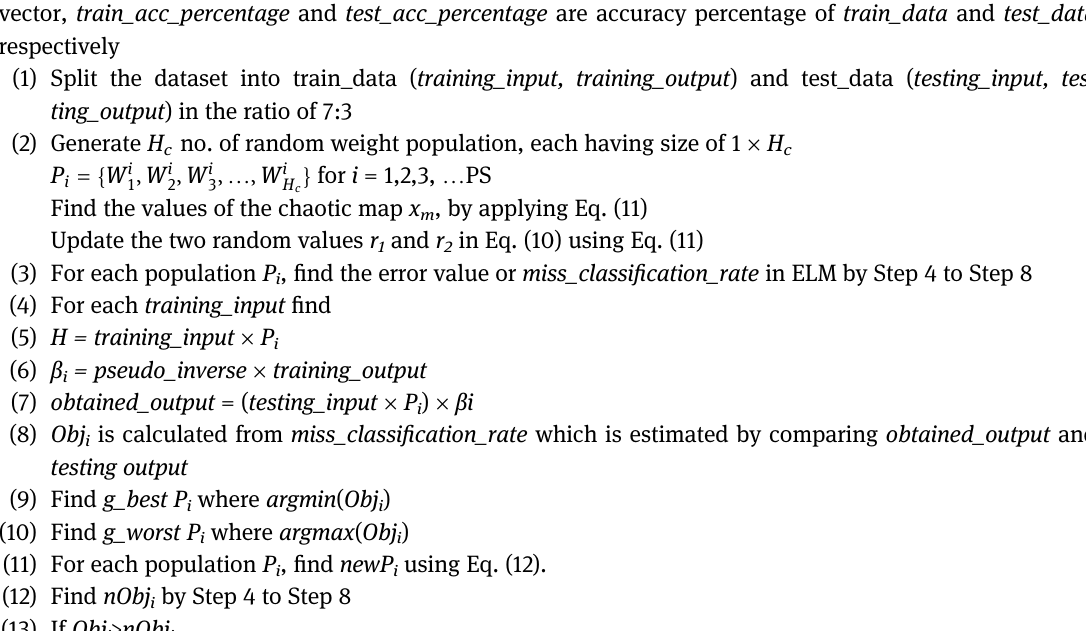
Algorithm: Pima diabetes data classification by using CJaya-ELM